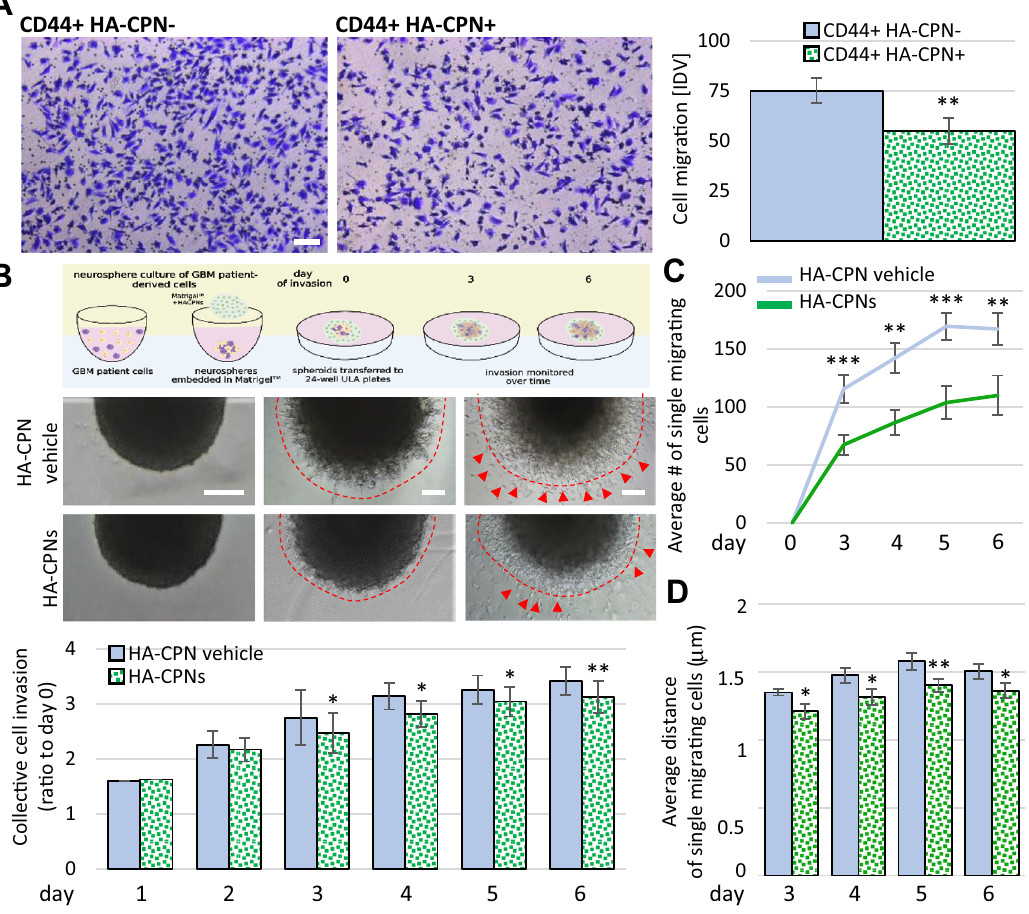
Figure 4. Treatment with HA-CPNs Regulates Migration and Invasion in Glioma. ( A ) Boyden chamber assay using CD44 + U-251 MG cells treated and FACS- enriched for HA-CPNs (CD44 + HA-CPN +) compared to HA-CPN- cells (CD44 + HA-CPN-). Representative images (left). Scale bar = 100 μm. Migrated cells scored in five fields of view per replicate over three replicates, using ImageJ as Integrated Density Value (IDV) (right); ( B, C ) Matrigel™ invasion assay using GBM patient derived spheres treated with HA-CPNs and/or HA-CPN vehicle control over a time course of six days. Schema of the protocol (top), representative images (mid panel). Scale bars = 100 μm; ( B ) Schema representing sphere invasion assay in Matrigel TM ; Created with BioRender.com (top) and collective invasion measured using ImageJ as change in sphere radius over time. Quantified values averaged over 6 spheres per treatment, per time point, over 3 patient cell lines (bottom). Leading edge assessed optically, marked by dashed line; ( C ) Average number of single cells migrating (red arrowheads in B ) scored using ImageJ per each Matrigel™- embedded sphere at the indicated timepoints; ( D ) Average distance of the single cell migration at the indicated timepoints. Data shown as mean ± s.d, n = 3, *p < 0.05, **p < 0.01, ***p < 0.001; Student’s t